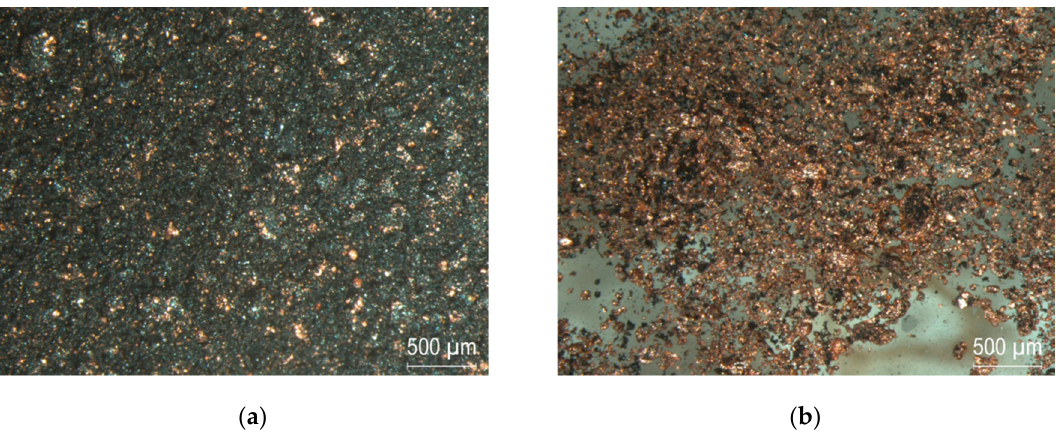
Figure 8. Products of magnetic separation of the thermally treated abrasion product of sample A: ( a ) Magnetic product at 8 mm distance between sample and magnet; ( b ) Nonmagnetic residue at 4 mm distance between sample and magnet.